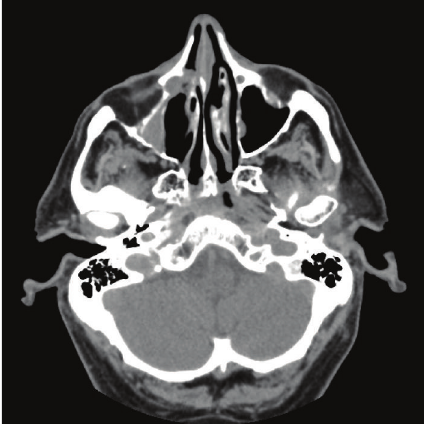
Figure 2: CT sinuses: axial section showing the lesion within the right nasolacrimal duct with evidence of bony remodelling.